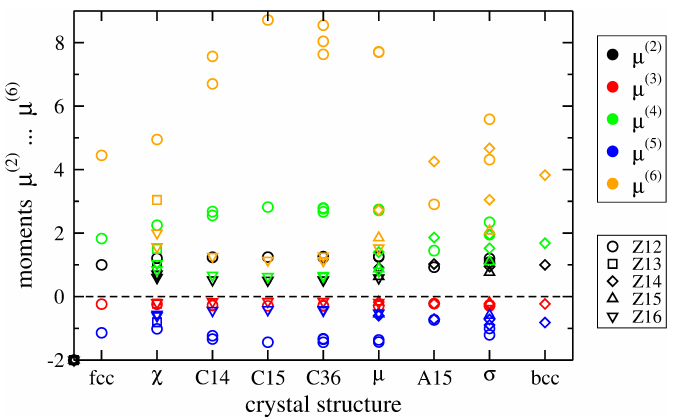
Figure 2. Second to sixth moments (colors) computed with a canonical d -valent TB model for DFT-relaxed crystal structures of Ta. Several values of the same moment (symbols) reflect the different environments of different Wyckoff positions. (This color coding is used in all following